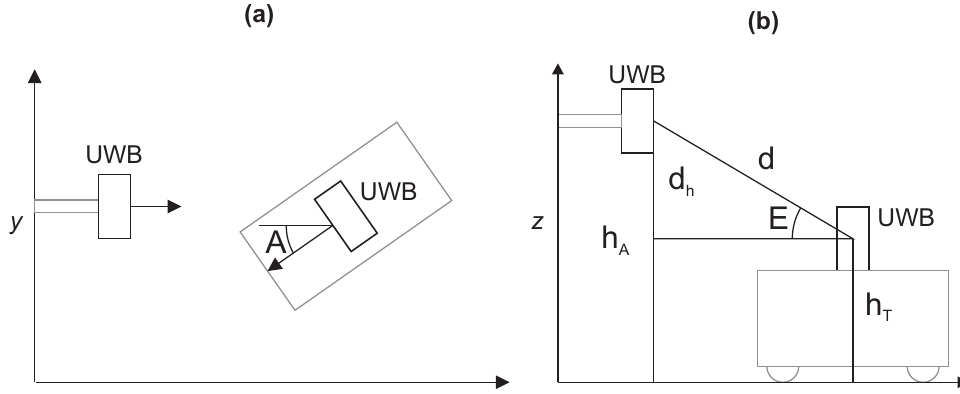
Figure 9. Tag’s azimuth and elevation relative to the individual anchor–tag pair. ( a ) The azimuth is computed from the anchor’s known orientation and the measured tag’s orientation around the z -axis in the reference coordinate system. ( b ) The elevation is obtained from the known heights of the anchor and tag and the distance between